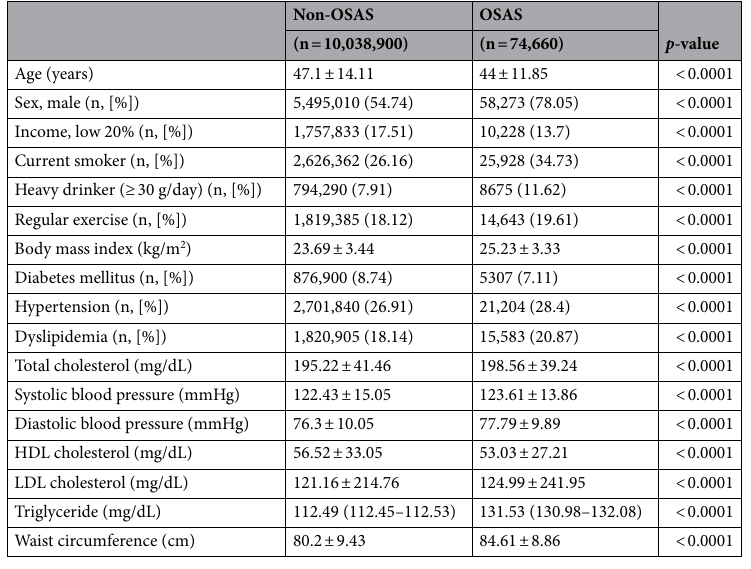
Table 1. Baseline characteristics of patients with OSAS and controls. OSAS: obstructive sleep apnea syndrome; LDL: low density lipoprotein; HDL: high density